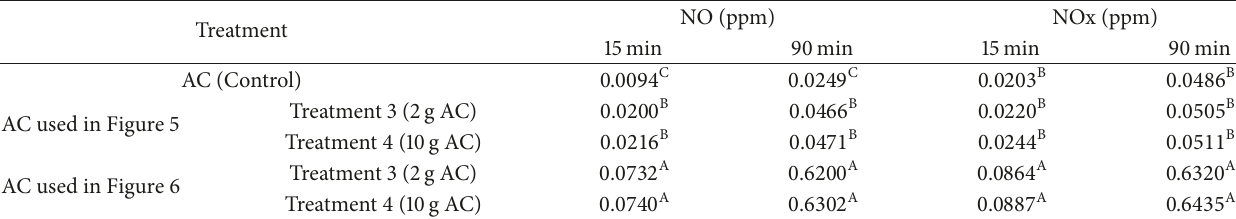
Table 2: The desorption rate of NOx at 60 ∘ C for different time.